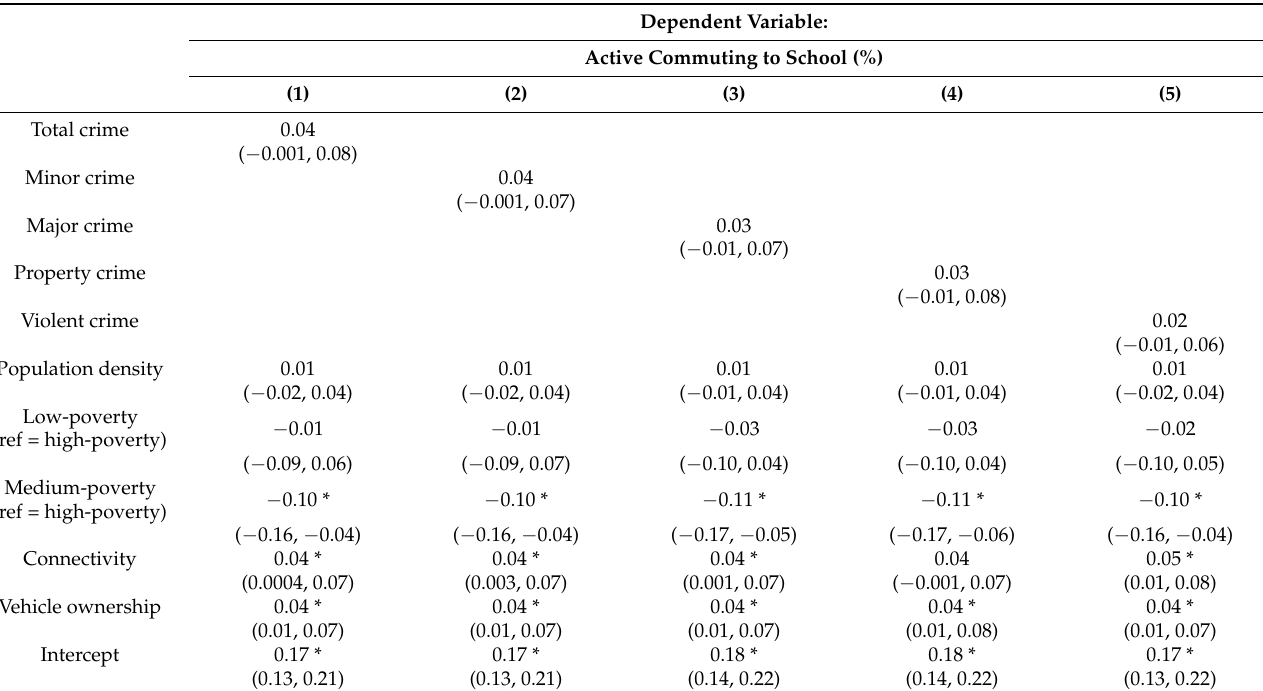
Table A2. Mutually adjusted models for police-reported crime types and